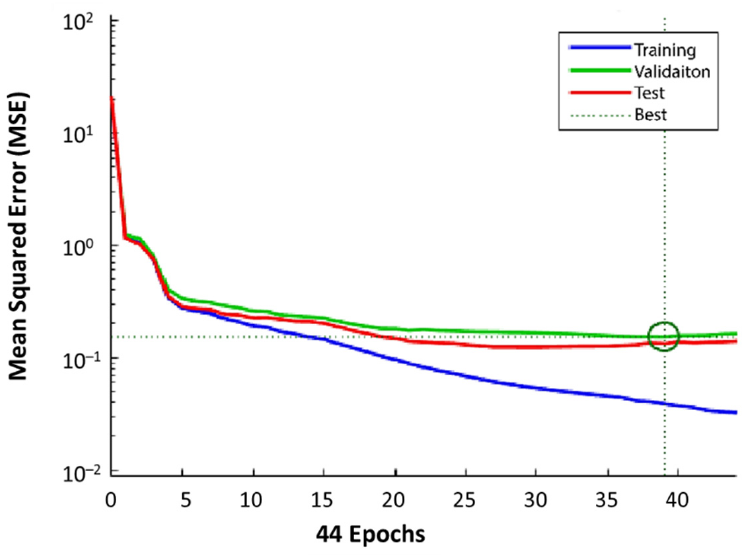
Figure 14. Mean squared error as a function of the number of iterations for training, validation, and testing performance in the transmitter number 1. The best validation performance is 0.15207 at epoch number 39.